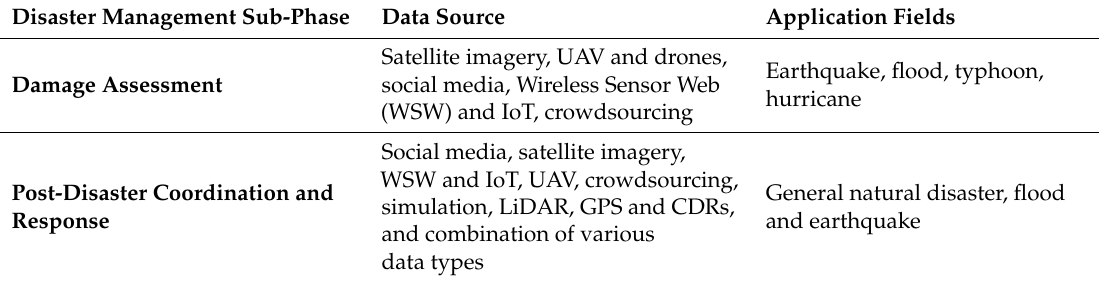
Table 1. Example of big data applications for disaster response